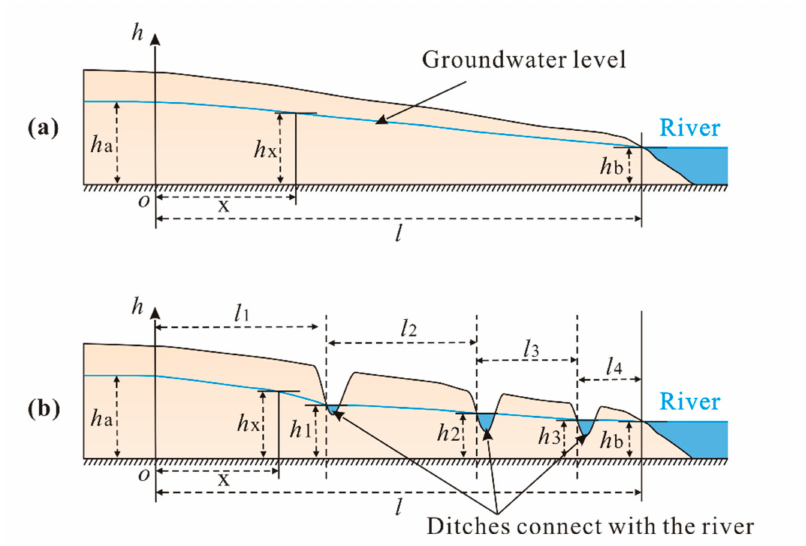
Figure 9. Schematic diagram of physical drainage measures. ( a ) Initial groundwater level, ( b ) the groundwater level after the physical drainage measures. h —is the groundwater level, l —is the distance between two water-passing sections, and x—is any point between two water-passing